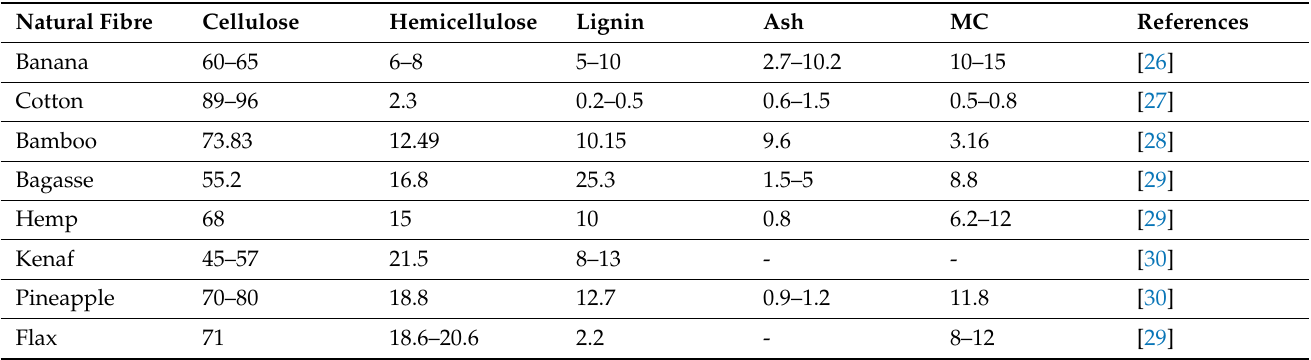
Table 2. The chemical composition of natural fibres. Data obtained from [25] Elsevier,